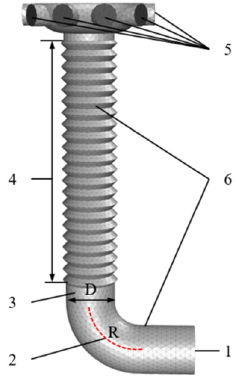
Figure 5. Simulation model. (1) inlet, (2) elbow radius of curvature, (3) pipe diameter, (4) corrugated pipe length, (5) outlet, (6) wall. The curvature–diameter ratio of the elbow refers to the ratio of the radius of curvature ( R ) and the pipe diameter ( D ) of the elbow. Table 2. Single-factor test parameters.